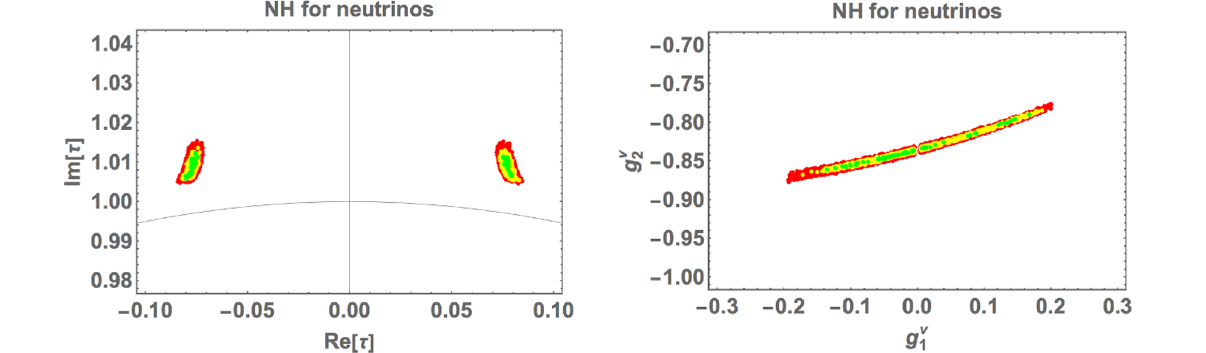
Figure 1 . Allowed regions of τ for NH. Green, yellow and red correspond to 2 σ , 3 σ , 5 σ confi- dence levels, respectively. The solid curve is the boundary of the fundamental domain, | τ | = 1 .